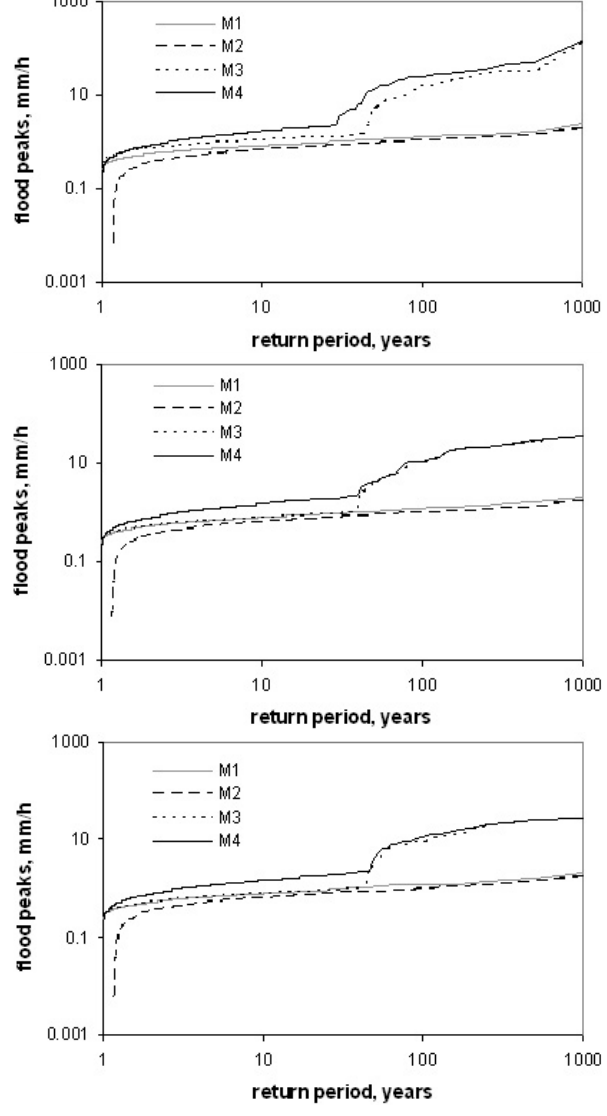
Fig. 7. Flood frequency curves for the four models using (a) η =0.5, (b) η =1.5, and (c) η =3, and S b =150mm.